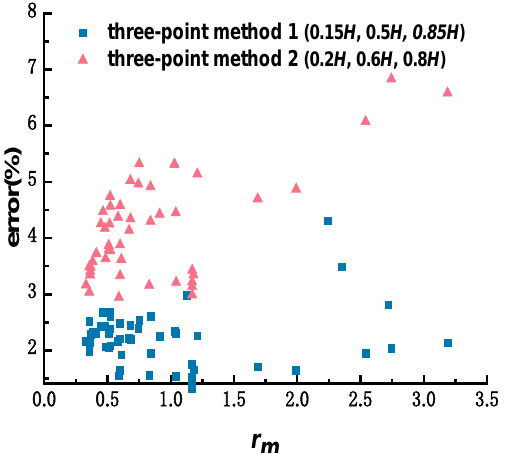
Figure 4. Comparison of velocity-estimation error related to two two-point methods.